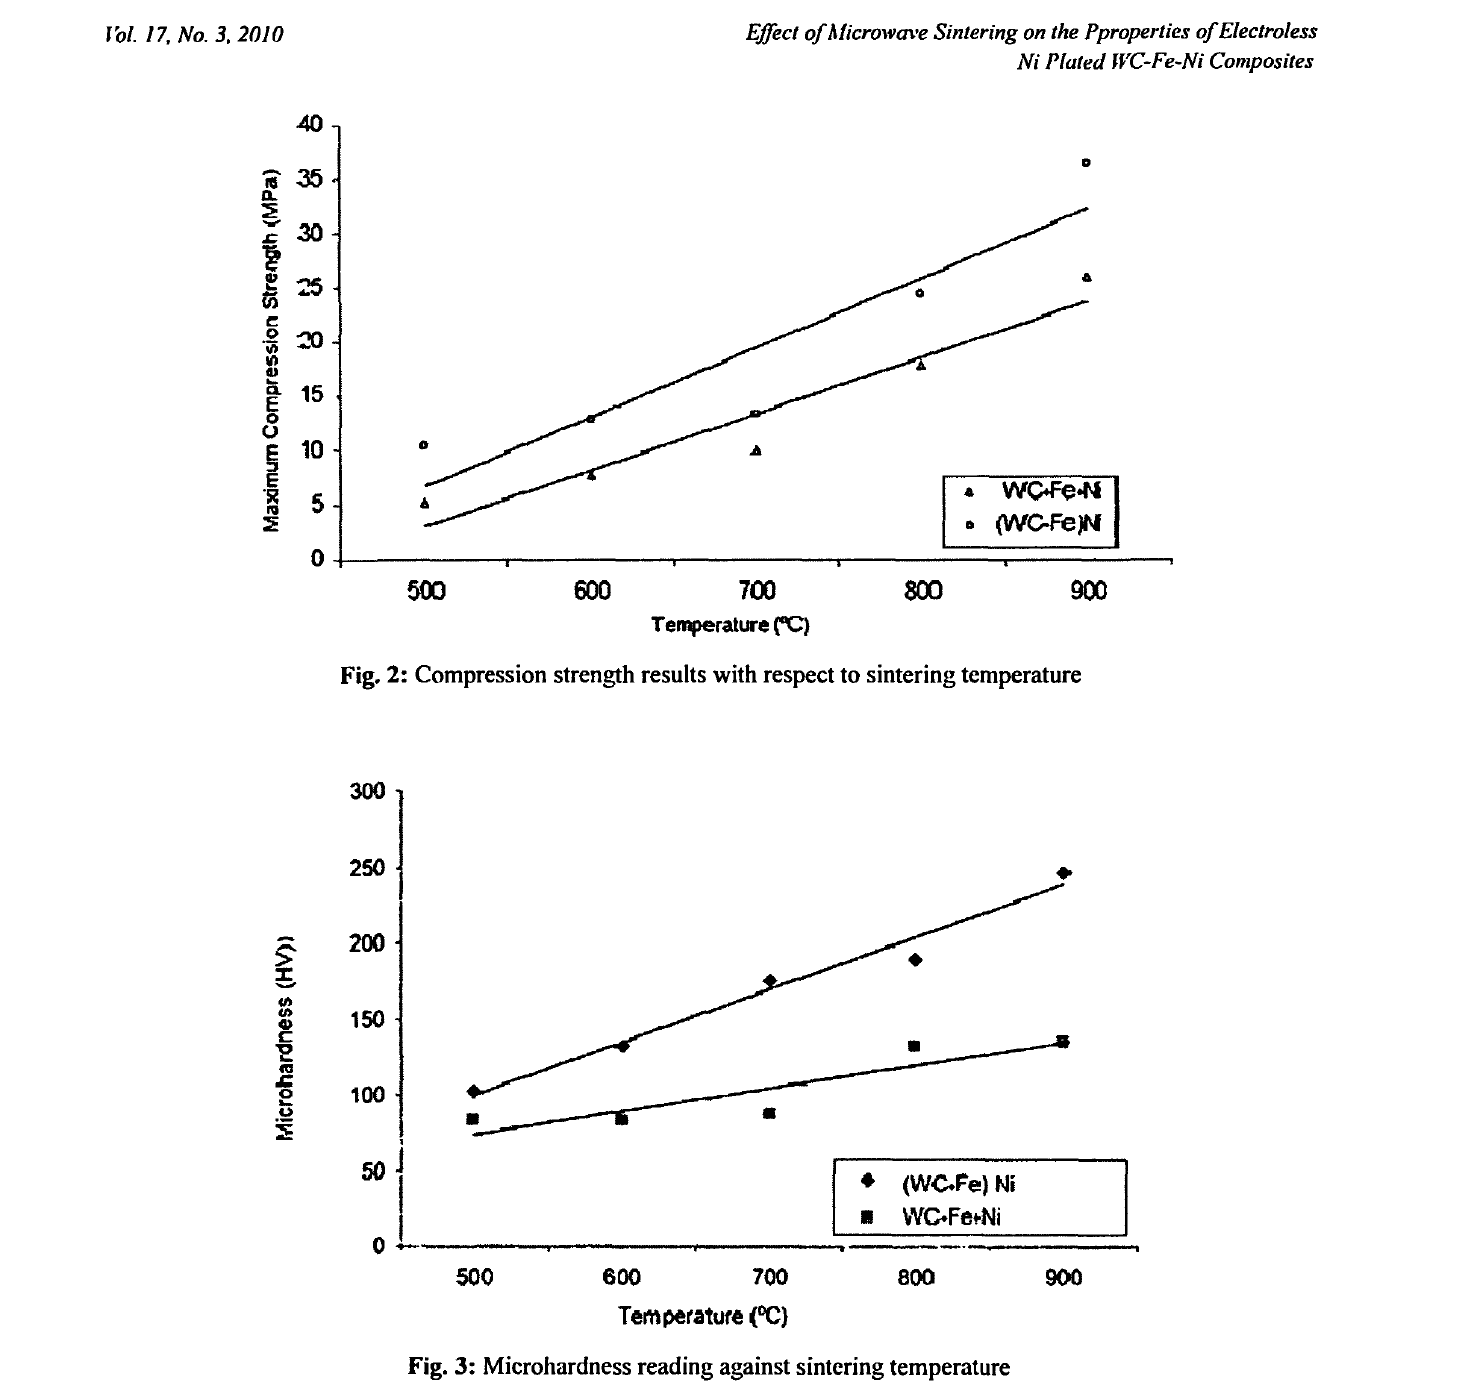
Fig. 3: Microhardness reading against sintering